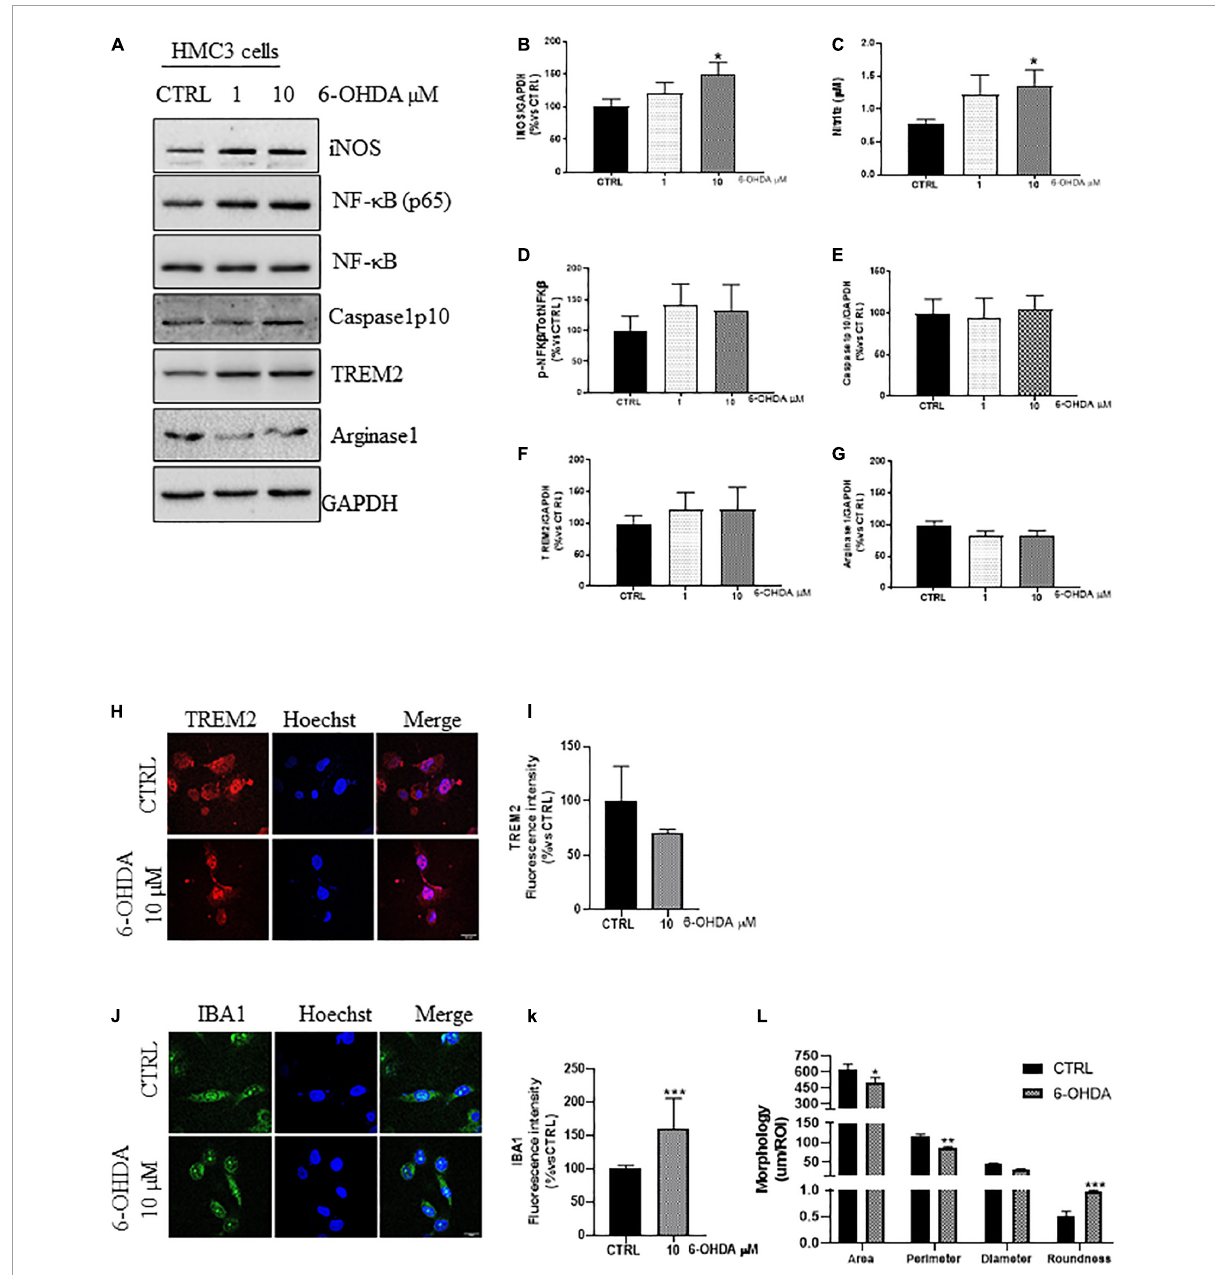
FIGURE2 Phenotypic markers expression in human microglial clone 3 cell line (HMC3) treated with increasing concentration of 6-OHDA. Western blot analysis and relative densitometry of iNOS (A,B) , NF- κ B(p65)/NF- κ B (A,D) , Caspase1p10 (A,E) , TREM2 (A,F) , and Arginase1 (A,G) , in lysed cells vs. the reference protein GAPDH and nitrite quantification in conditioned medium (C) of HMC3 cell treated with increasing concentration of 6-OHDA (0, 1, and 10 µ M) for 24 h. Results are the mean ± s.e. of independent experiments. N = 3 for Caspase1, NF- κ B(p65)/NF- κ B, and IBA1. N = 4 for TREM2, N = 5 for iNOS and Arginase1. Representative immunofluorescence and relative quantification of fluorescence intensity of TREM2 (H,I) , and IBA1 (J,K) and morphology analysis of IBA1 + cells (J,L) in HMC3 cells treated with 6-OHDA 10 µ M for 24 h. N = 3. Scale bar = 20 µ M. One-way ANOVA, followed by Dunnett’s test * p < 0,05, ** p < 0.01, and *** p < 0.001 vs.